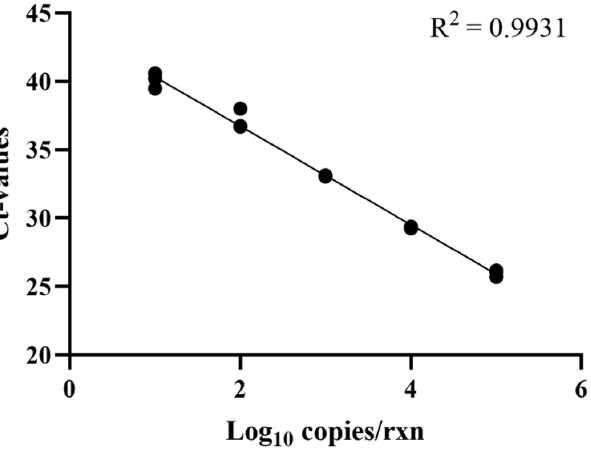
Figure 2. Standard curve of the SARS-CoV-2 N gene obtained using the Sansure Biotech SARS-CoV-2 detection kit.